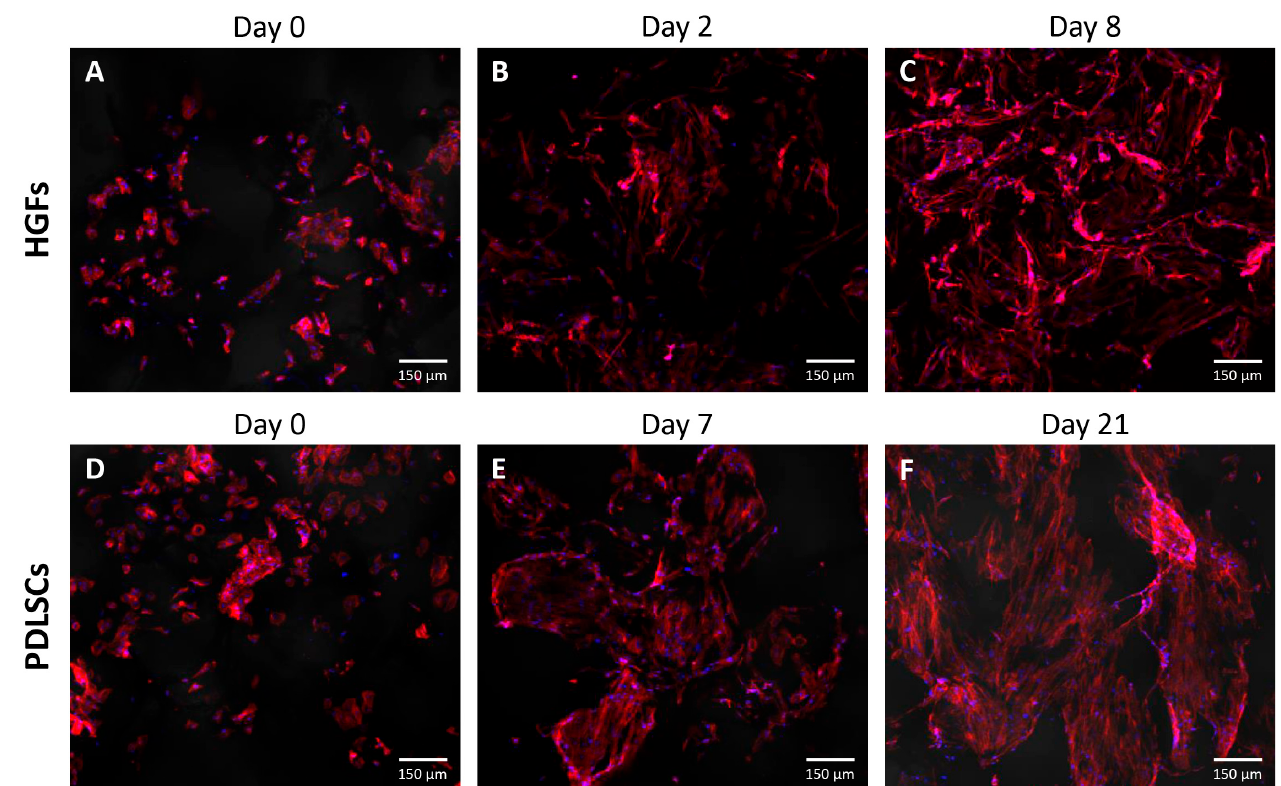
Figure 7. Confocal micrographs of the ( A – C ) HGF and ( D – F ) PDLSC cells cultured on the P(HB- 50HV) scaffold. Cell nucleus was stained with Hoechst 33342 (blue). F-actin was stained with Alexa Fluor 568 phalloidin (red).